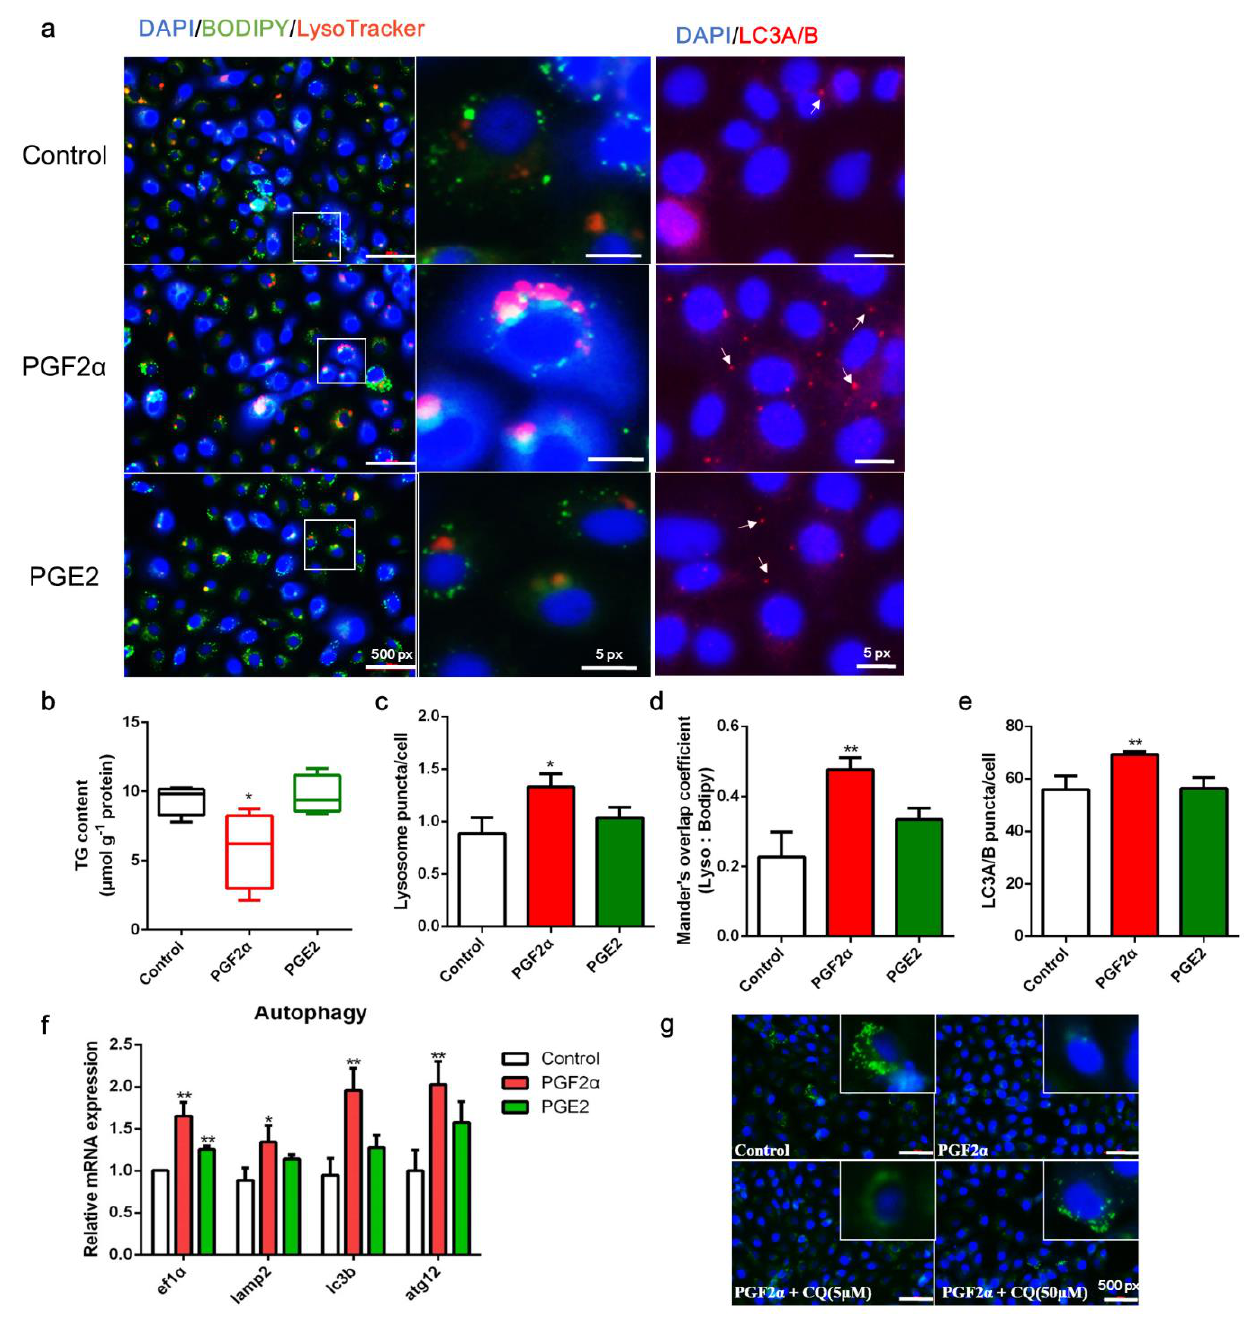
Figure 4. Effects of PGF2 α and PGE2 on autophagy and lipid accumulation in zebrafish liver cells. Cells were incubated with or without PGF2 α (10 µ M) and PGE2 (10 µ M) for 24 h. ( a ) Lipid droplets (LDs) were stained with BODIPY (green), nuclei were stained with DAPI (blue), lysosomes were stained with LysoTracker (red), and LC3A/B was stained with a specific immunofluorescent antibody (red). ( b – e ) Triglyceride (TG) content ( n = 4), relative fluorescence of lysosome puncta ( n = 3) and LC3A/B ( n = 3), and Mander’s overlap coefficient of lysosome/BODIPY ( n = 3) in each image were quantified using ImageJ software ( n = 4). ( f ) Relative transcript expression of autophagy-related genes ( n = 3). ( g ) Cells were pre-incubated with autophagy inhibitor CQ, then treated with PGF2 α for 24 h; the LDs and nuclei were stained with BODIPY and DAPI, respectively. ATG12, autophagy- related 12; EF1 α , elongation factor 1 α ; LAMP2, lysosomal-associated membrane protein 2; LC3b, microtubule-associated protein 1 light chain 3b. Statistical significance is denoted with asterisks as follows: * p < 0.05; ** p <